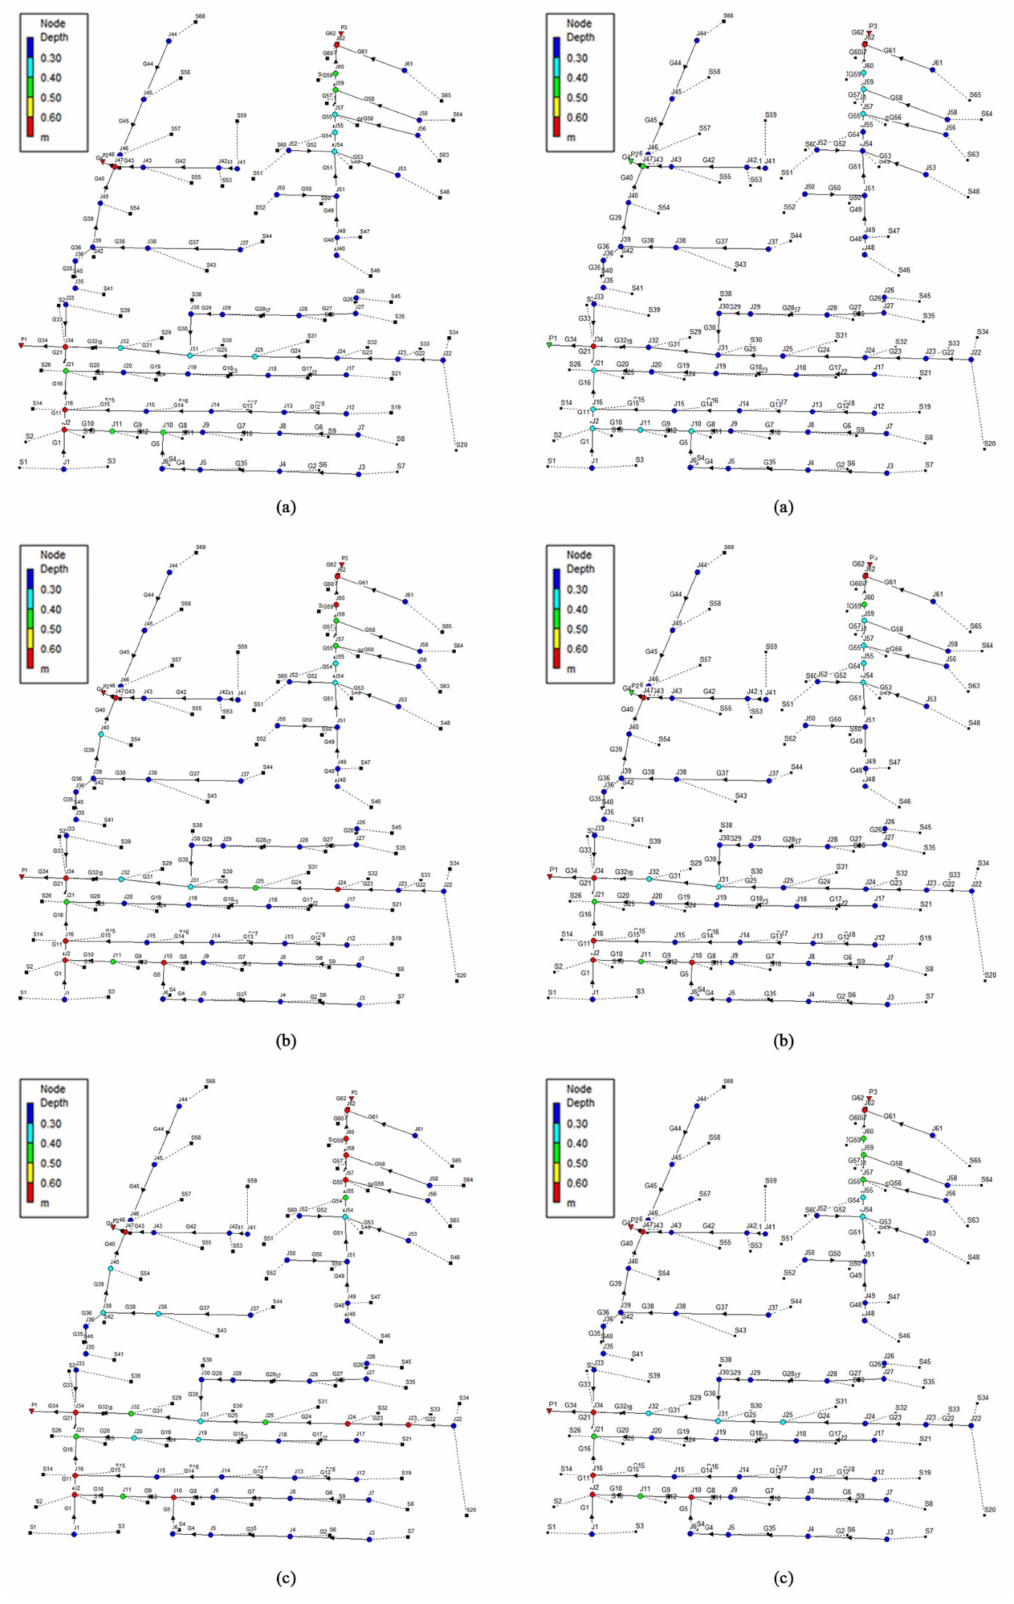
Figure 9. Flood simulation of each node for Scenario 1 (left) and 2 (right) under storm conditions with 5-, 10-, and 20-year recurrence intervals: ( a ) 5-year; ( b ) 10-year; ( c ) 20-year. Different colors represent different capacities for floodwater from each node, respectively. Red nodes indicate the high capacity of floodwaters, and blue the low